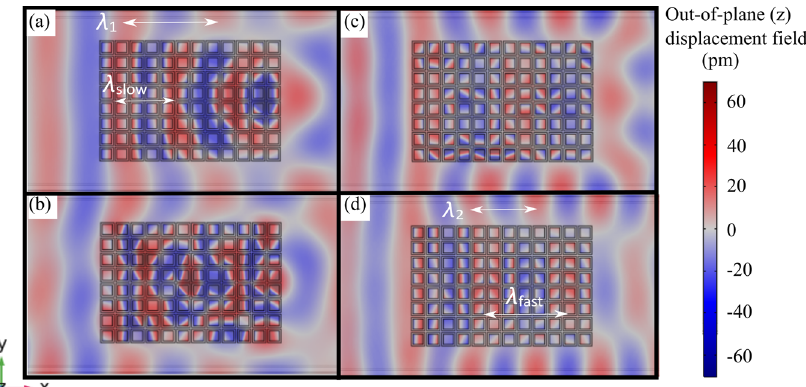
Fig. 3 Simulated out-of-plane ( z ) displacement fi elds. Simulated out-of-plane ( z ) displacement fi elds for ( a – b ) slow and ( c – d ) fast phase velocities obtained from model con fi guration (2). Observed at frequencies of ( a ) 90 MHz, ( b ) 97 MHz, ( c ) 110 MHz and ( d ) 120 MHz. The wavelength inside the array (Array#1) is shorter and longer than that of the unpatterned surroundings for frequencies that have slow ( a – b ) and fast ( c – d ) phase velocities, respectively. Data obtained using COMSOL Multiphysics ® 38 .